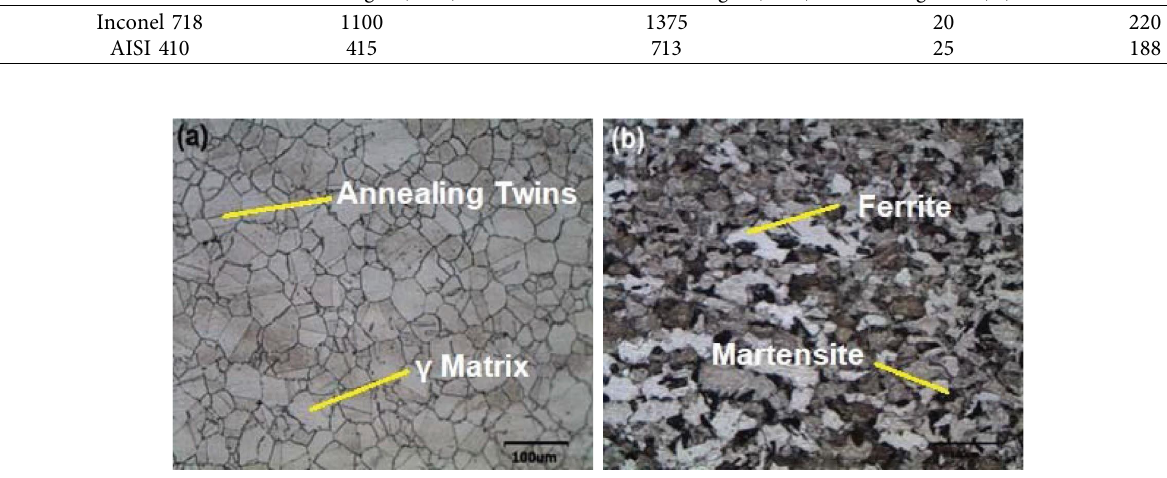
Figure 1: Base metal microstructure (a) Inconel 718 and (b) AISI 410.